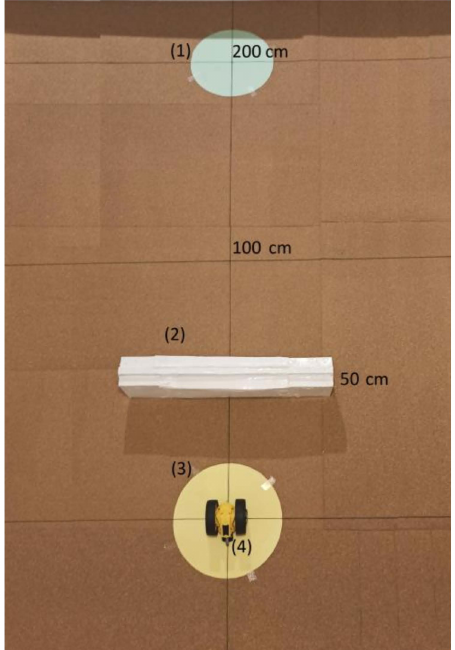
Figure 7. Scenario with one obstacle: (1) goal, (2) obstacle, (3) home, and (4)